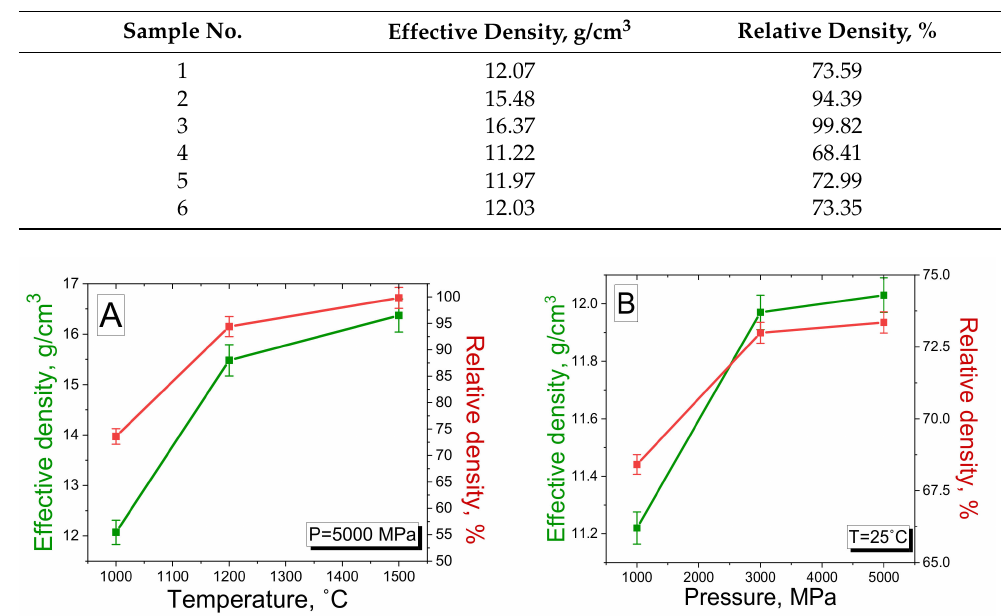
Table 3. The effective and relative densities of the I type of W–Cu composite samples.